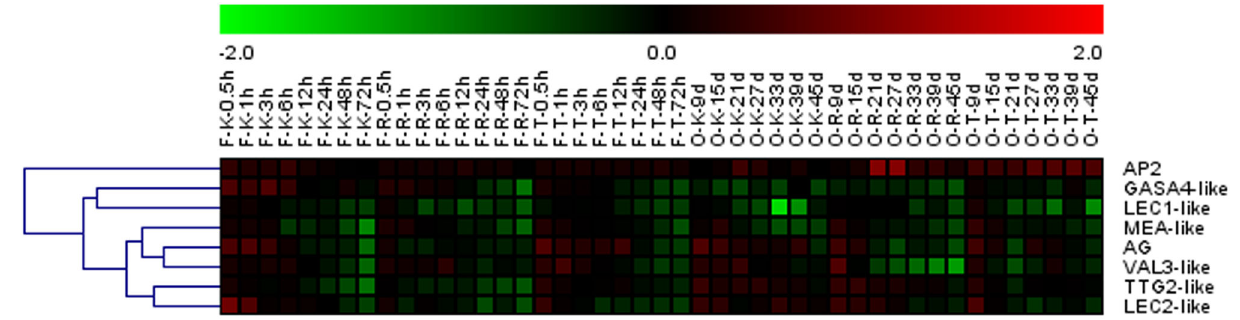
Figure 6. Hierarchical clustering of genes related to seed development in three grape cultivars following GA treatment. Results of semi-quantitative RT-PCR assays were quantified using GeneTools software, and log-transformed values of the relative expression levels of genes involved in seed development following GA used for hierarchical cluster analysis. The color scale represents relative expression levels with red denoting up-regulation and green denoting down-regulation. Sampling times are indicated at the top of the figure; F represents floral tissue; K represents the ‘Kyoho’ cultivar; S represents seed tissue; R represents the ‘Red Globe’ cultivar; T represents the ‘Thompson seedless’ cultivar.